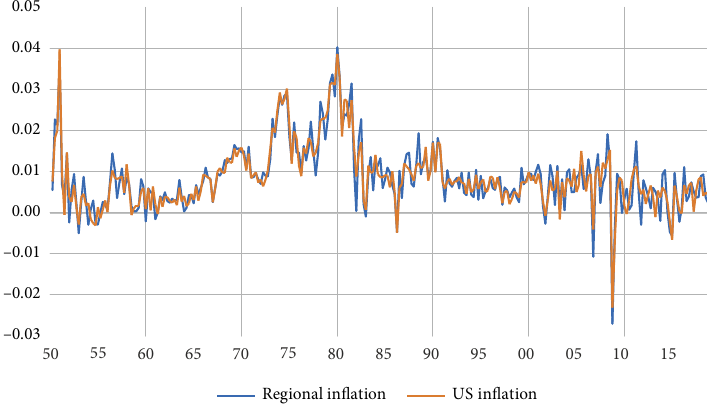
Figure 1. US vs average regional inflation Table 1. Descriptive statistics of US and regional